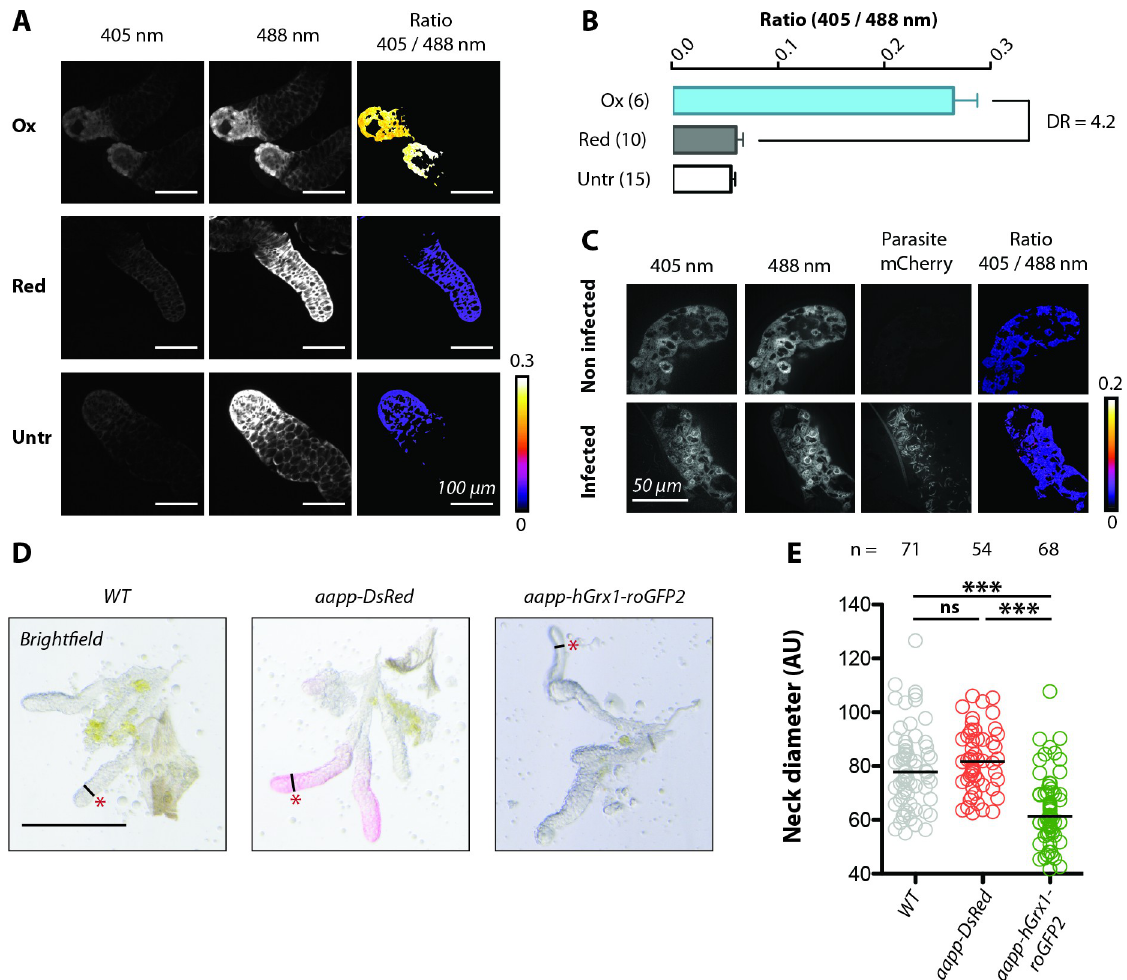
Fig 6. hGrx1-roGFP2 expressed in the salivary glands is functional but affects gland morphology. A) Dissected salivary glands expressing hGrx1-roGFP2 were incubated in diamide (ox), dithiothreitol (red) or N-ethylmaleimide (untr) and imaged at 405 nm and 488 nm wavelengths. The 405/488 ratio is given in false colors to indicate the oxidation level of the glutathione pool. Scale bars: 100 μ m. B) Quantification of glutathione oxidation based on the 405/488 ratio. Salivary glands were treated as in (A). Numbers in parentheses indicate the number of examined salivary glands. DR: dynamic range. C) Image of a salivary gland infected with mCherry -expressing P . berghei sporozoites. Staining and imaging were performed on two consecutive days with � 10 salivary glands per experiment. A representative image is shown. Scale bar: 50 μ m. D) Brightfield images of salivary glands from wild type ( G3 ), aapp-DsRed and aapp-hGrx1-roGFP2 females. The „neck region” of the distal-lateral lobes is indicated by a red asterisk and the measured diameter by a black line. Between 54 and 71 images were acquired for each line in � 3 independent preparation and imaging sessions. Representative images presented here were all acquired in the same session. Scale bars: 250 μ m. E) Diameter measurements of the distal-lateral lobe neck region of aapp-DsRed and aapp- hGrx1-roGFP2 in comparison to wild type ( G3 ). The number of measurements is indicated above each genotype. Note that only the diameter of one distal-lateral lobe per gland was measured. Data represent � 3 independent experiments. The black line indicates the median. ��� p < 0.0001, one-way-ANOVA (Bonferroni’s Multiple Comparison Test). ns: not